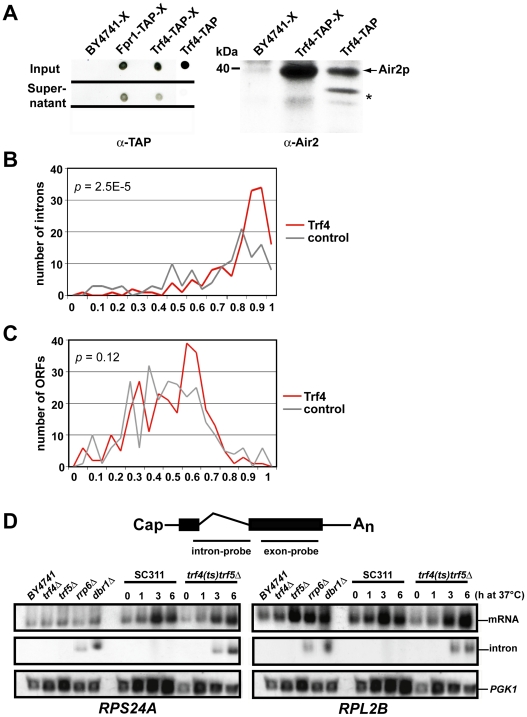
Selective enrichment of introns in TRAMP4 affinity–isolates.(A) RNA–protein complexes were purified from extracts of cells expressing recombinant Trf4-TAP protein after in vivo cross-linking with formaldehyde (Trf4-TAP-X). Extracts of BY4741 cells and of cells expressing Fpr1-TAP were used as control (BY4741-X; Fpr1-TAP-X). Affinity purification of the Trf4-TAP protein complex or Fpr1-TAP from the WCEs was monitored by dot blot (left panel) and immunoblot (right panel) analyses with antibodies detecting the calmodulin-binding region of the TAP-tag (α-TAP) or the Air2p subunit of the TRAMP4 complex (α-Air2). Input and supernatant correspond to cross-linked WCEs before and after immunopurification, respectively. Affinity purified TAP-tagged Trf4 protein complex from non cross-linked WCEs was used as a positive control for the purification procedure (Trf4-TAP). A molecular weight marker is shown next to the immunoblot; * denotes likely Air2p degradation products. (B, C) Percentile rank analysis of immunopurified RNA preparations. RNAs enriched by TAP-tag affinity purification was comparatively analyzed to total RNA purified from WCEs with DNA microarrays. The enrichment profiles of introns (B) and the respective ORFs (C) were created by binning average percentile ranks from three biological replicates of Trf4-TAP or control IPs (two replicates of Fpr1-TAP and one untagged cells) into 0.05 unit bins. P-values to estimate the difference between Trf4 and control data were calculated with the Kolmogorov-Smirnov test. (D) Northern analysis with intron- and exon- specific probes in RNA surveillance mutants (trf4Δ, trf4Δ/TRF4-DADA, trf5Δ, and rrp6Δ) and in the debranching enzyme dbr1Δ mutant strain. Strains were grown at 30°C in YPD, except SC311 and trf4(ts)trf5Δ
[25] that were shifted to 37°C for the indicated times prior to RNA extraction.